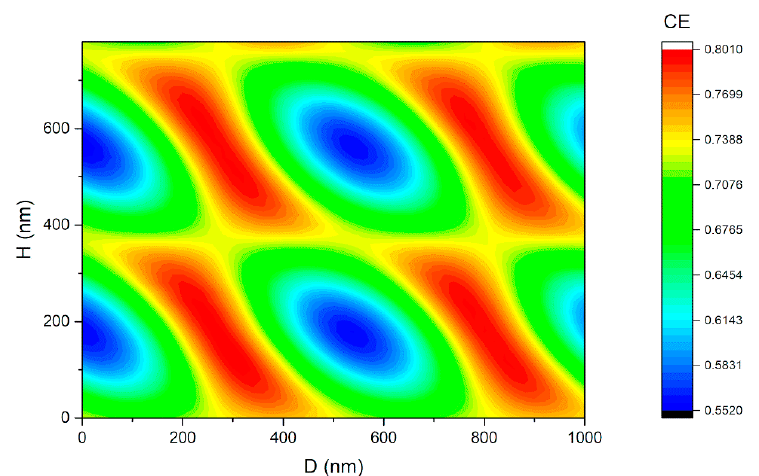
Figure 6. The CE at 1550 nm with H varying from 20 nm to 800 nm and D varying from 0 nm to 1000 nm. The CE changes periodically with the value of H and D .